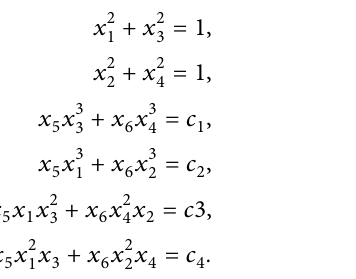
( t ) using different 3